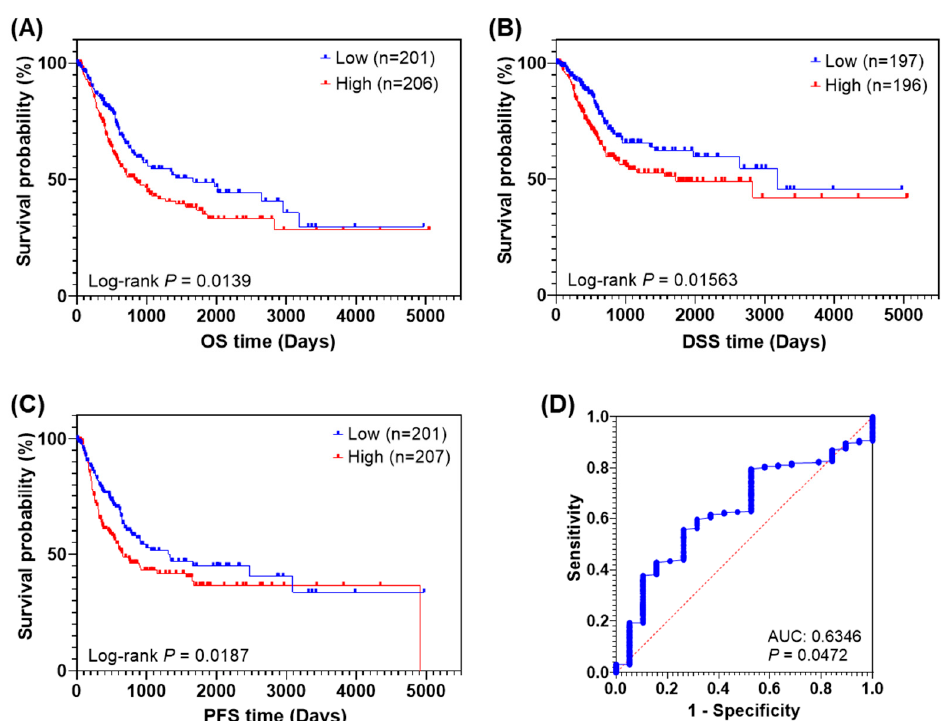
Figure 2. High expression of AnxA2 predicts poor prognosis in TCGA-BLCA patients. Patients in the high AnxA2 expression group had shorter OS ( A ), DSS ( B ), and PFS ( C ) compared with those in the low AnxA2 expression group. Log-rank p -value of <0.05 was considered statistically significant. ( D ) AnxA2 can distinguish the tumor and normal status in BLCA datasets.